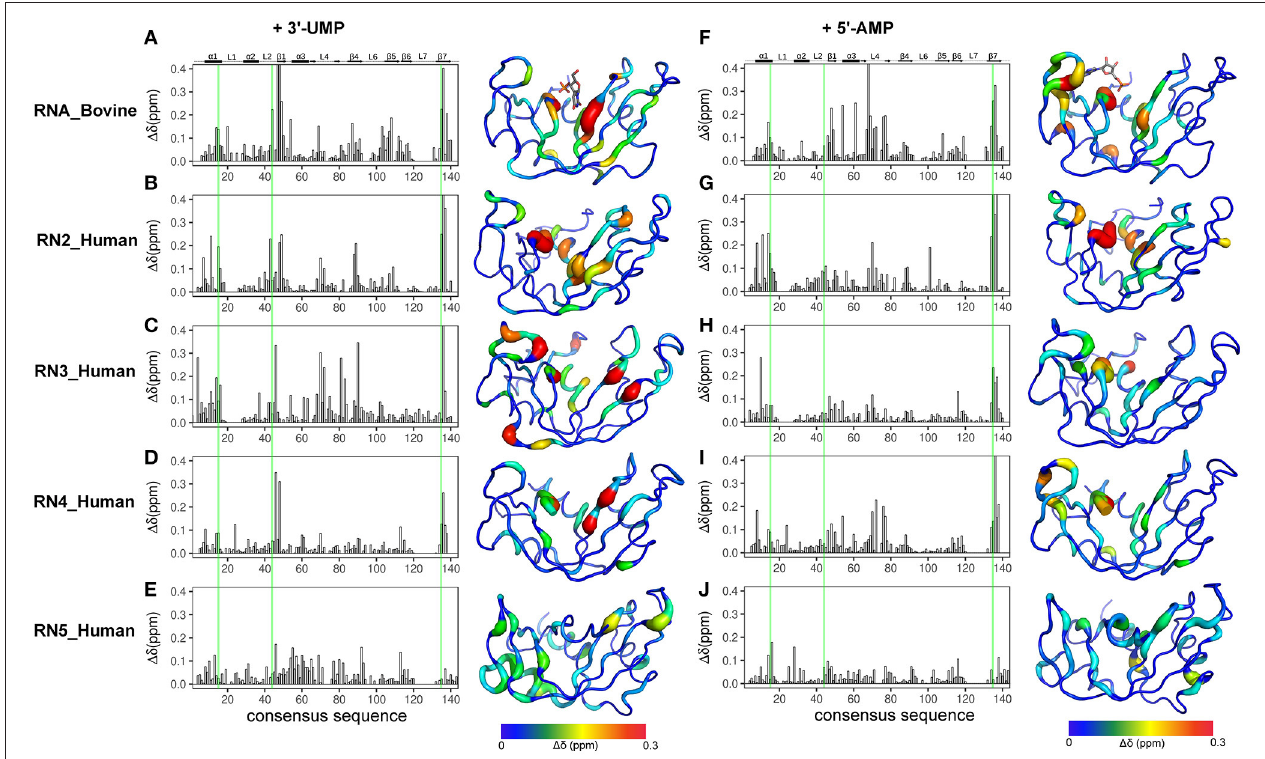
FIGURE 3 | Effect of 3 ′ -UMP and 5 ′ -AMP ligand binding on functionally distinct RNases. Compounded chemical shift perturbations ( 1 δ obs at the highest ligand concentration) relative to the apo form upon binding of two mononucleotides 3 ′ -UMP (A–E) and 5 ′ -AMP (F–J) for bovine RNase A (A,F) and human RNases 2 (B,G) , 3 (C–H) , 4 (D,I) , and 5 (E,J) are plotted as function of consensus sequence. Active-site residues (His12, Lys41, His119, RNase A numbering) are highlighted using green lines. Chemical shift perturbations were calculated by comparing the shifts at the largest enzyme:ligand molar ratios relative to the apo state for each enzyme. 1 δ obs are shown using the putty representation on the 3D structures to the right of the plots. Secondary structure of bovine RNase A is traced on top of the sequence alignment using blocks, arrows and dashed lines to represent α -helix, β -strand and loop regions, respectively. The 3 ′ -UMP and 5 ′ -AMP ligand positions, depicted on the structures of RNase A (A,F) , were obtained from PDB entries 1O0N and 1Z6S, respectively.